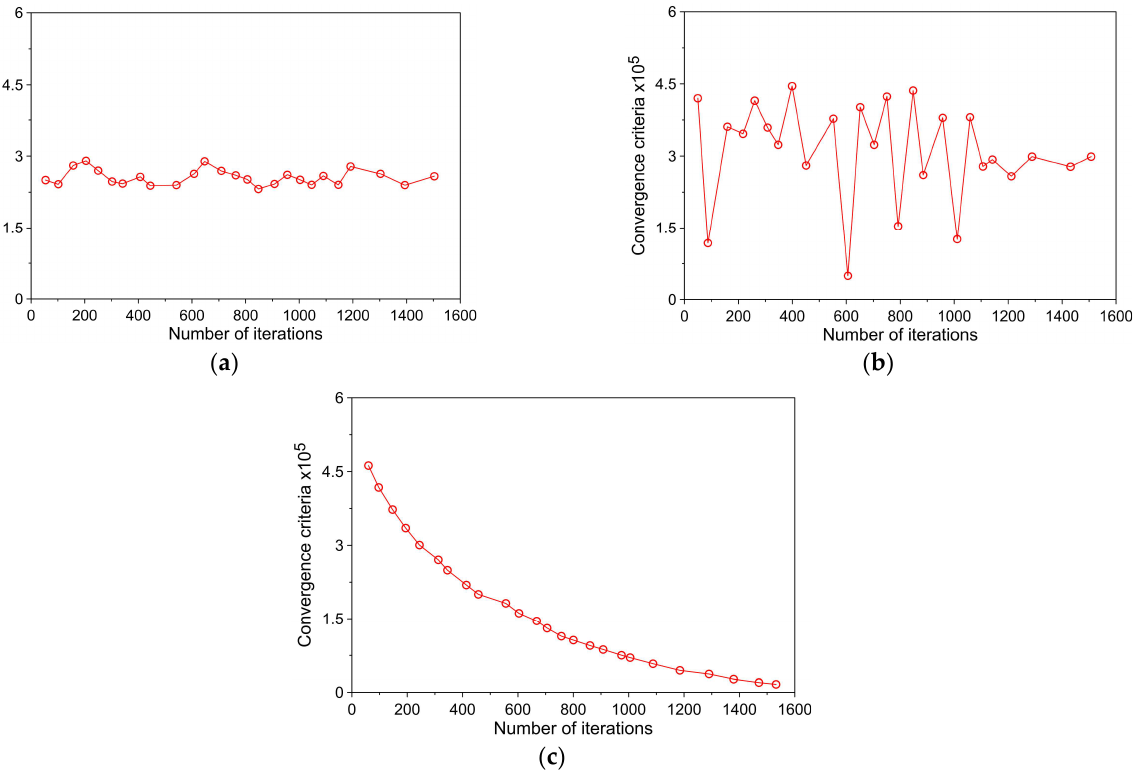
Figure 3. Convergence criteria of turbulence models: ( a ) 𝑘 − 𝜀 , ( b ) 𝑅𝑁𝐺 𝑘 − 𝜀 , and ( c ) 𝑆𝑆𝑇 𝑘 − 𝜔 .